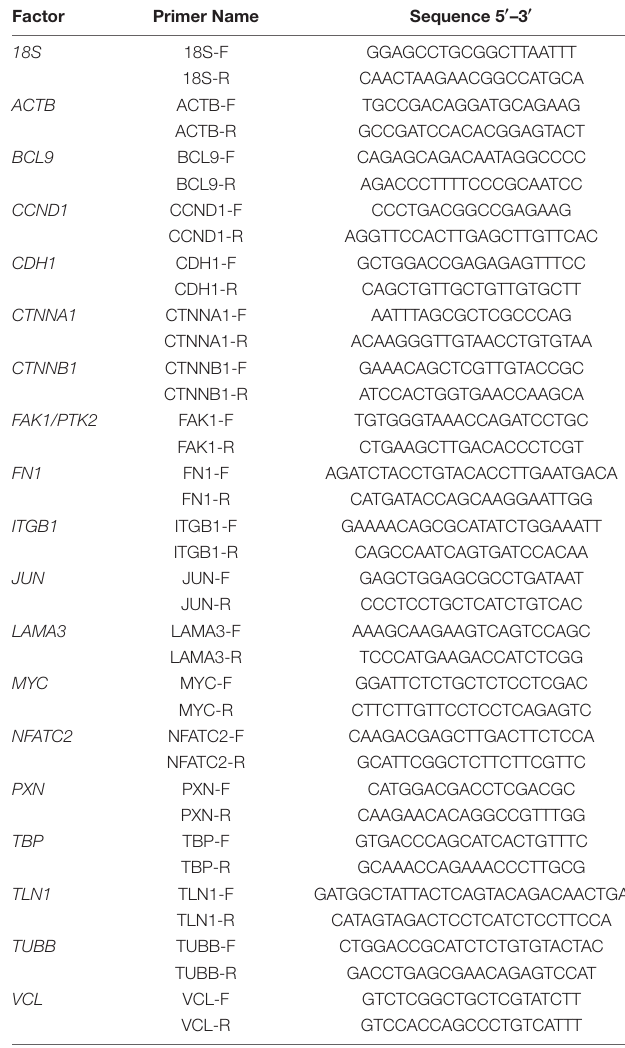
TABLE 2 | List of all the primers’ sequences used in the quantitative PCR. All the sequences are listed in the 5 (cid:48) -3 (cid:48) -direction.